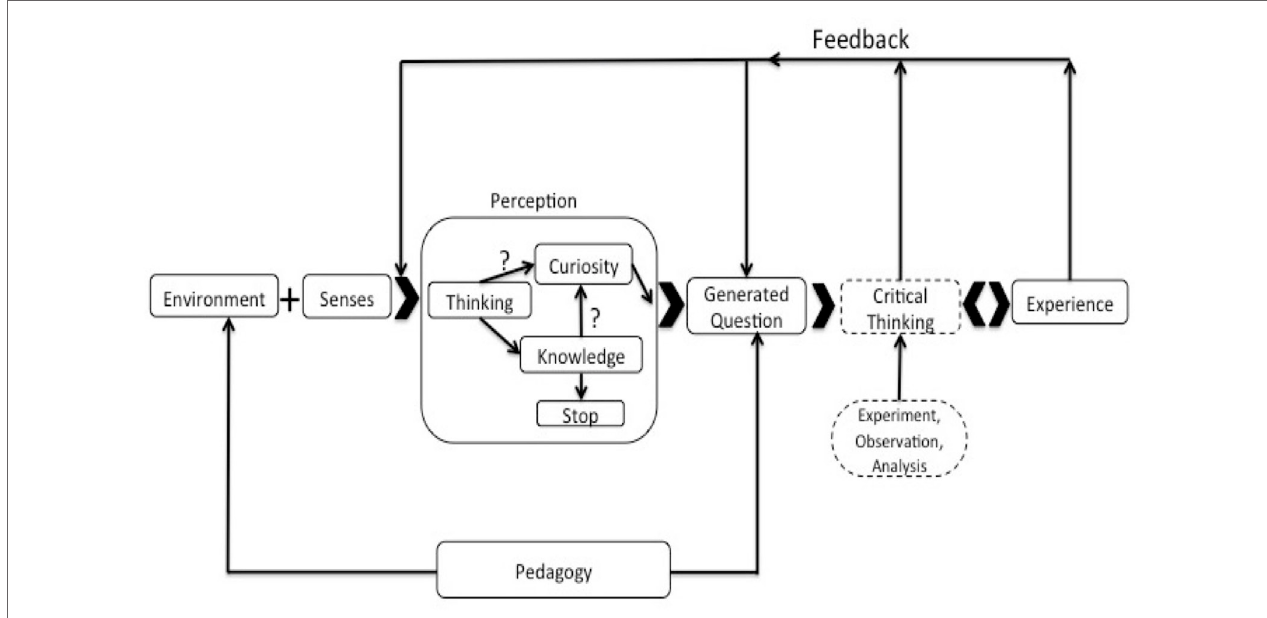
FiGUre 1 | The generated questions learning model (Crogman and Trebeau Crogman,